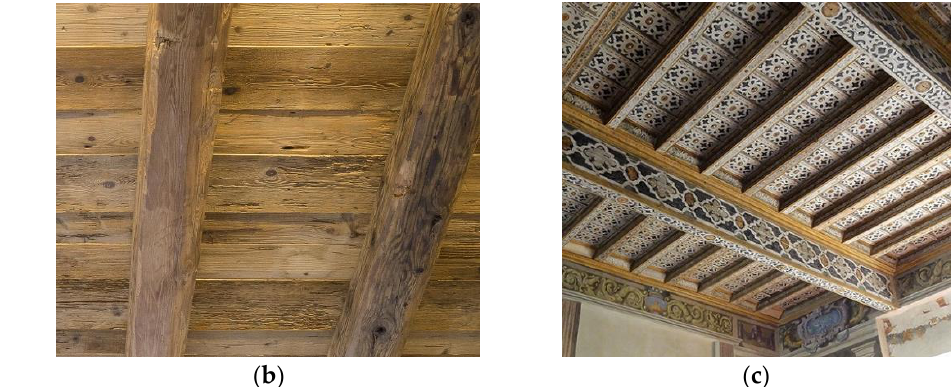
Figure 1. ( a ) Tiles, rafters, and beams; ( b ) timber beams and boards; ( c ) decorated timber beam floor: tiles, and two layers of rafters and beams.